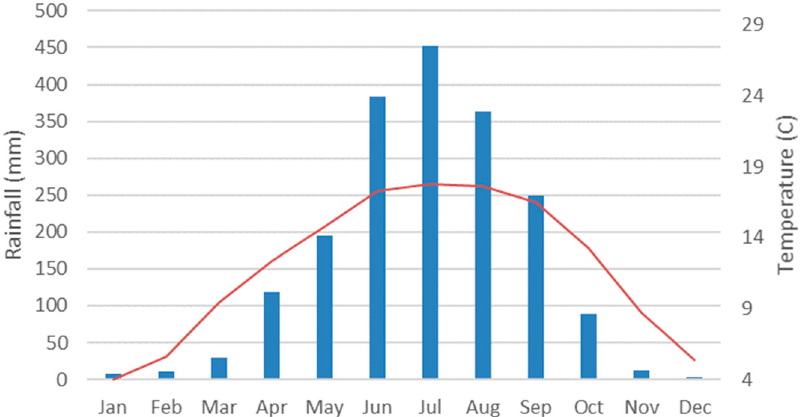
Figure 3. Average monthly temperature and rainfall of Bhutan (Data source: World Bank Group [52]).